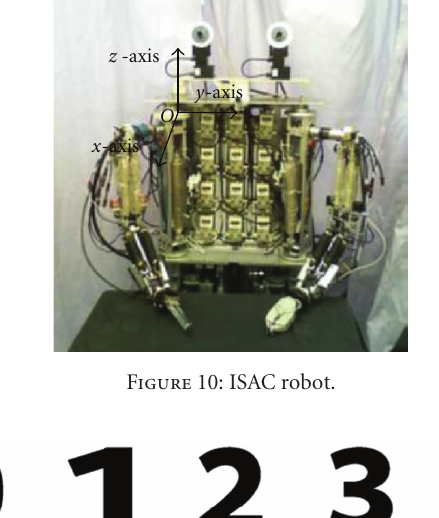
Figure 13: Dimension reduction results of the original ISOMAP